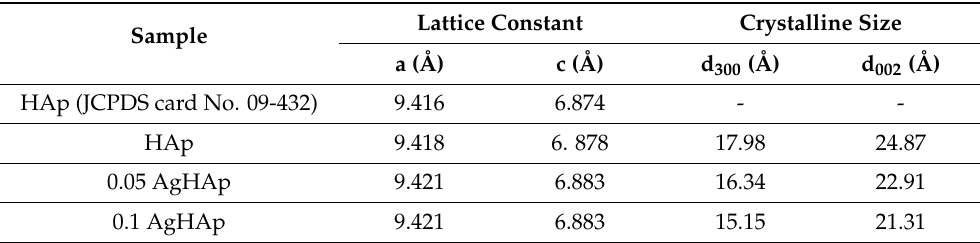
Figure 1. XRD patterns of the HAp in red, 0.05 AgHAp in blue, 0.1 AgHAp in black and of pure hydroxyapatite (JCPDS no. 9-0432) in pink. Table 1. Lattice constant and crystalline sizes calculated from the XRD patterns of the HAp, 0.05 AgHAp and 0.1 AgHAp thin films.